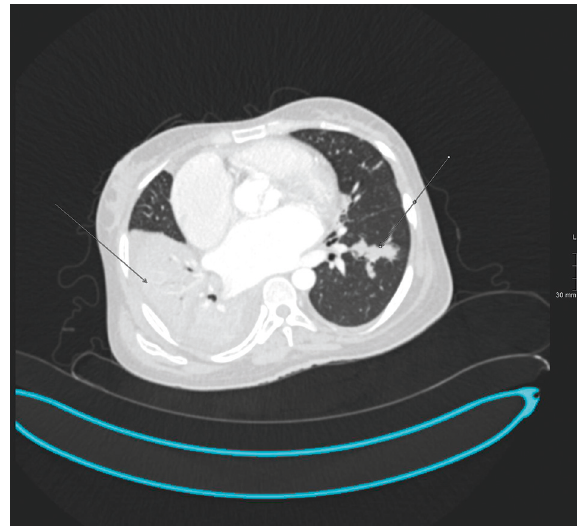
Figure 2: CT chest axial image showing bilateral lung